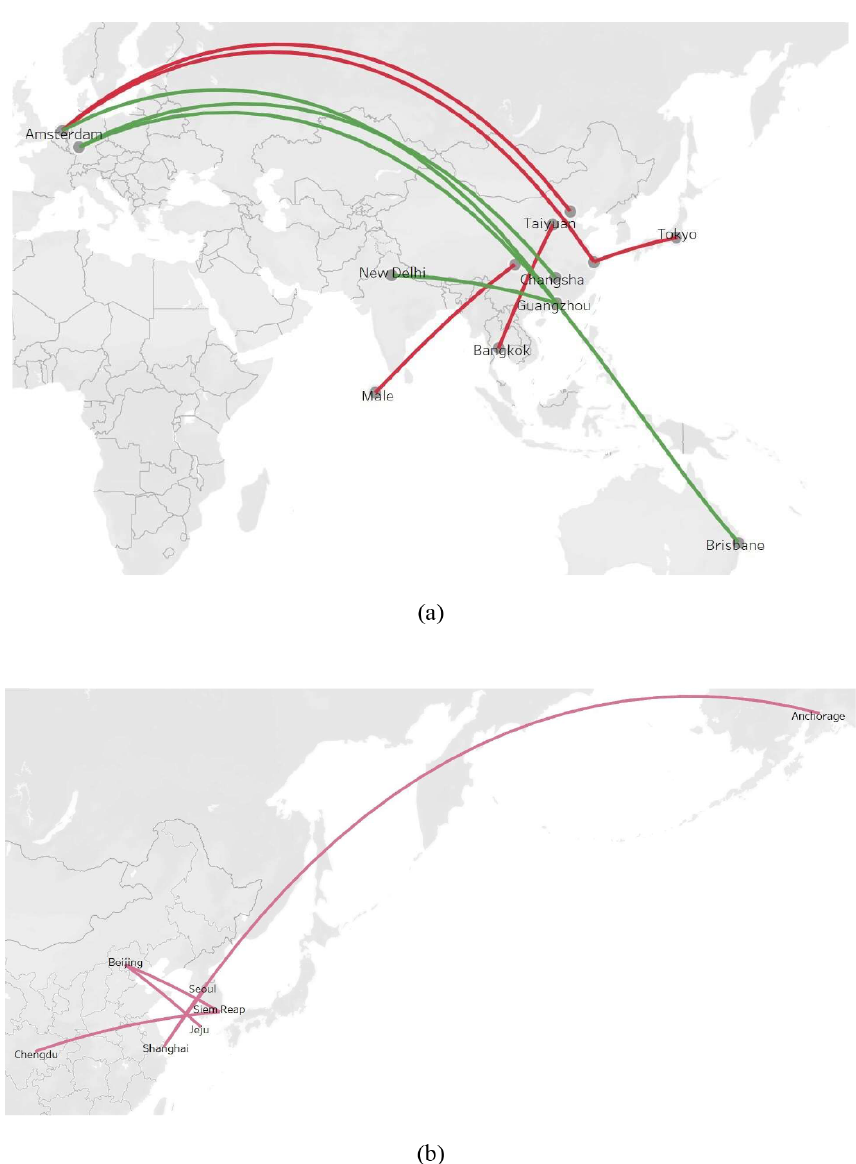
Figure 10. The impacts of CNG2020 on some popular routes. (a) The largest increase and the largest reduction routes in average unit turnover carbon emissions before and after the CNG2020 strategy was proposed. (b) The strategy proposes the path of minimum change of average unit turnover carbon emissions before and after the CNG2020 strategy was